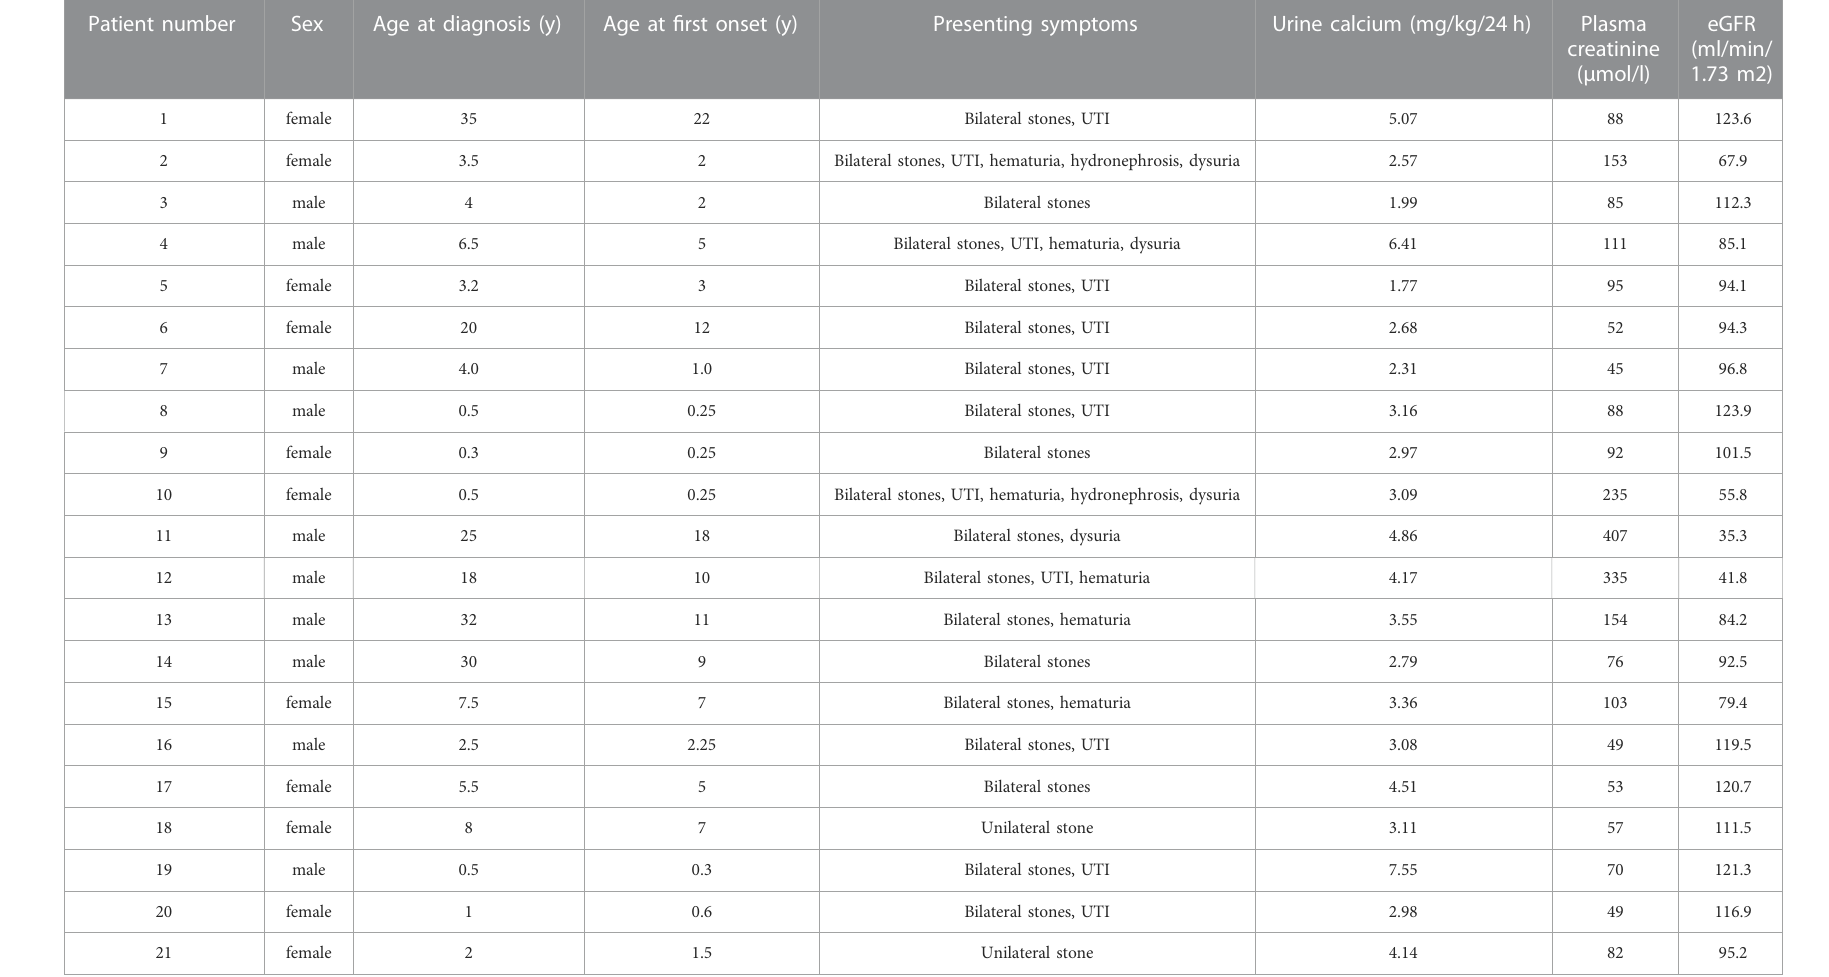
TABLE 3 Clinical and biochemical characteristics of primary hyperoxaluria